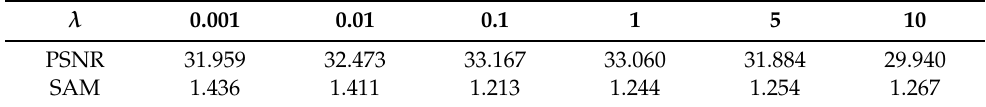
Table 3. PSNR and SAM of SSRN with different λ on the WDCM database.